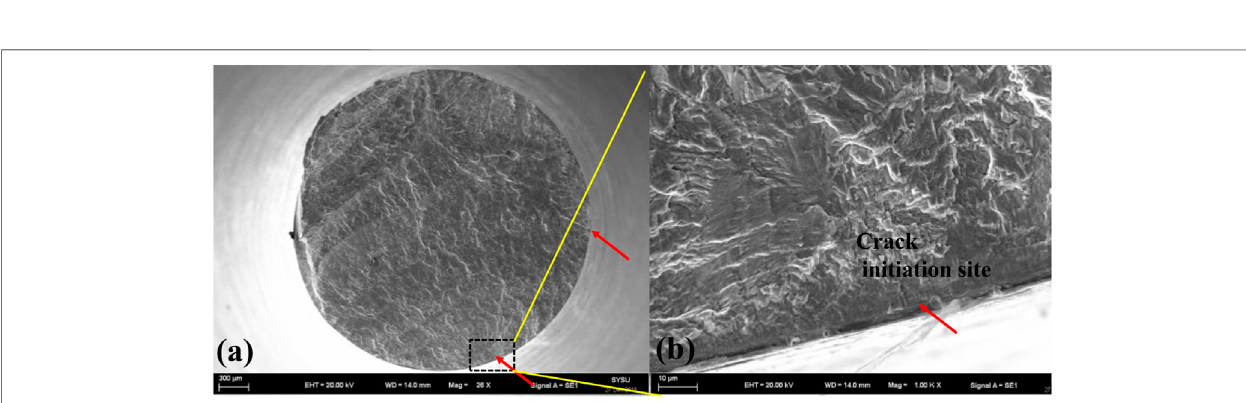
Frontiers in Energy Research |